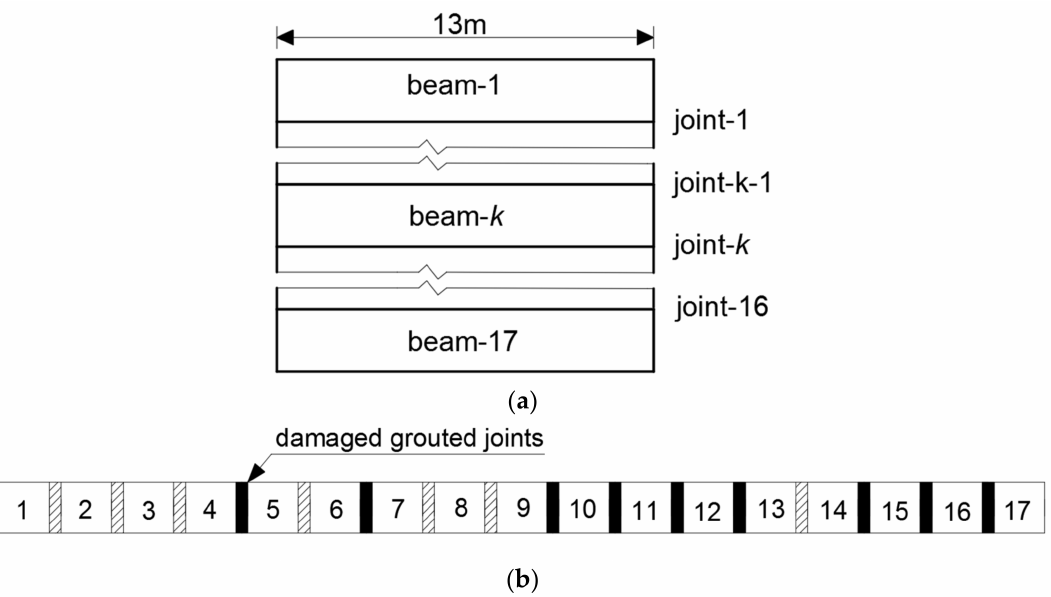
Figure 4. ( a ) Arrangement of numbers of beams and joints of Baidong No. 2 Bridge. ( b ) Location of damaged joints of Baidong No. 2